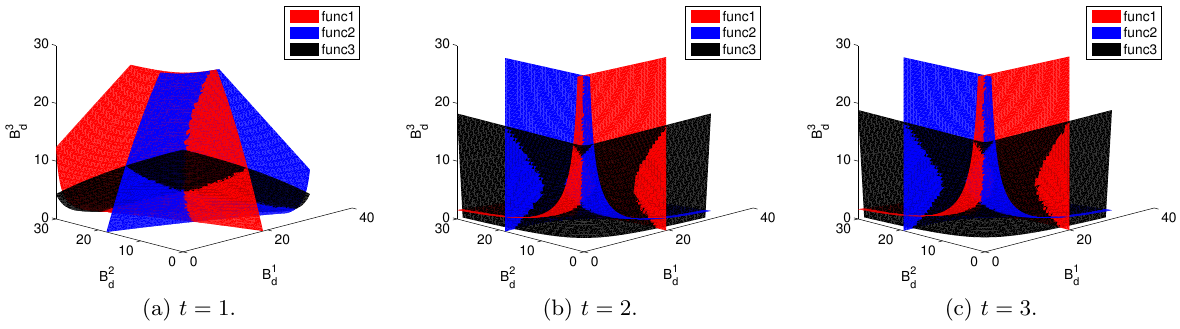
Figure 3: NE evaluations for the second simulation scenario when a = 0 . 01 . B 1 (1) + B 2 (1) resources. d d Figure 3 draws the NE evaluations for the second simulation (b), (c), the NE is improved with game repeat, which is aligned with the insights provided by Figure 2. While